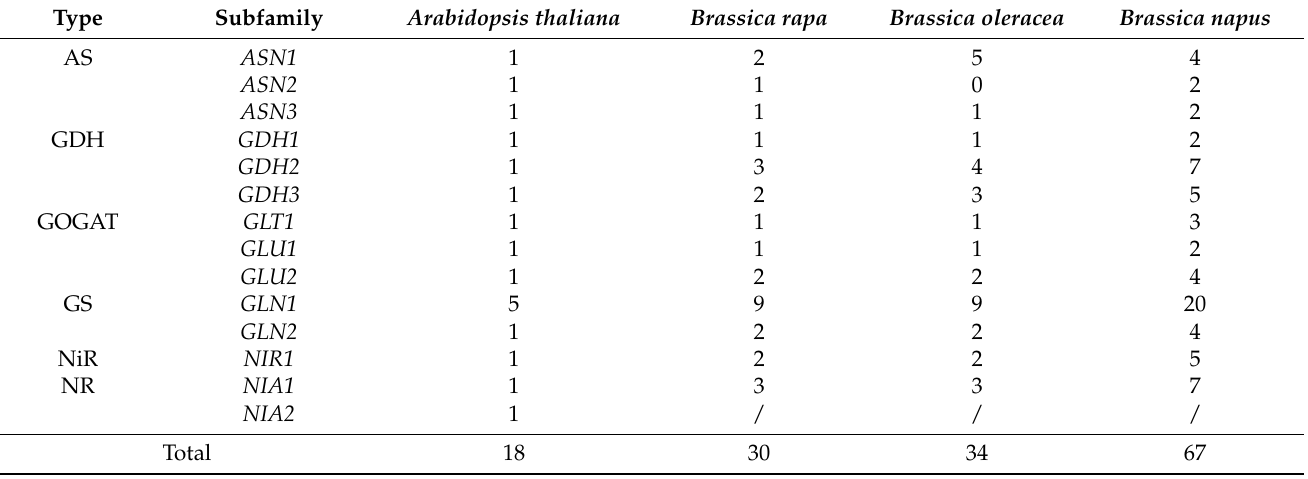
Table 1. Copy number variation of the N assimilation related gene family in Arabidopsis and three Brassica species.